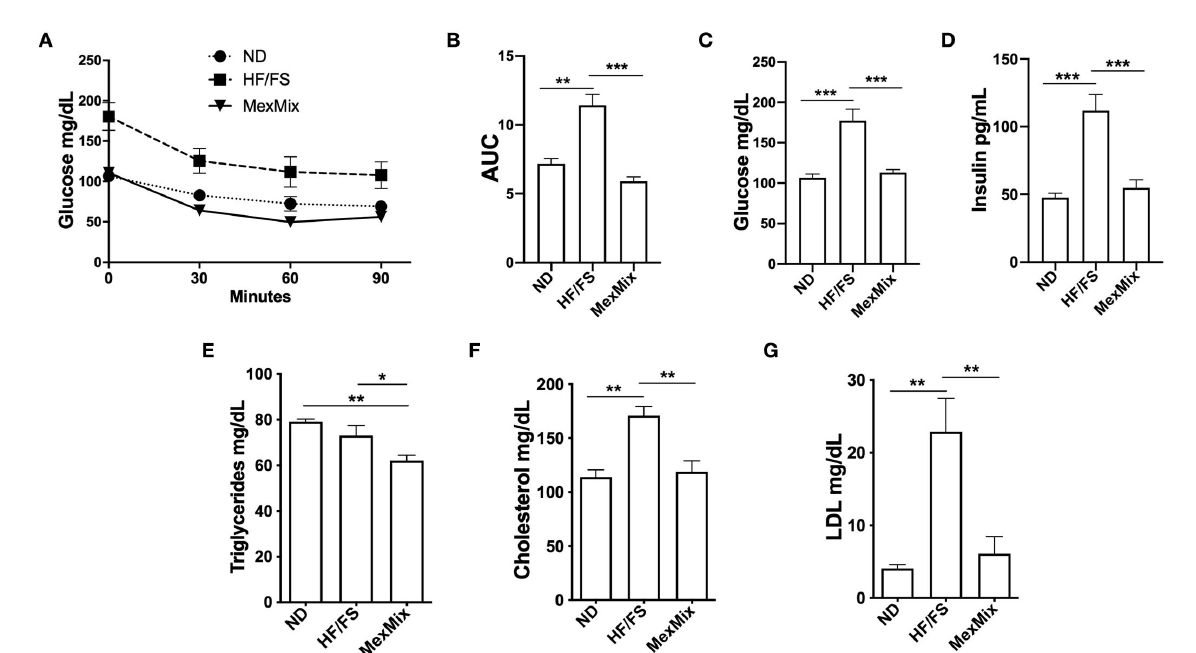
FIGURE2 Effect of MexMix diet in glucose and lipid metabolism. (A) ITT test: glucose serum levels at 0, 30, 60, and 90 minutes. (B) Total area under the curve calculated from the ITT data. (C) Serum glucose levels. (D) Serum insulin levels. (E) Triglyceride levels. (F) Cholesterol levels. (G) LDL cholesterol levels. Data are expressed as mean ± SEM (* p < 0.05; ** p < 0.01; *** p <